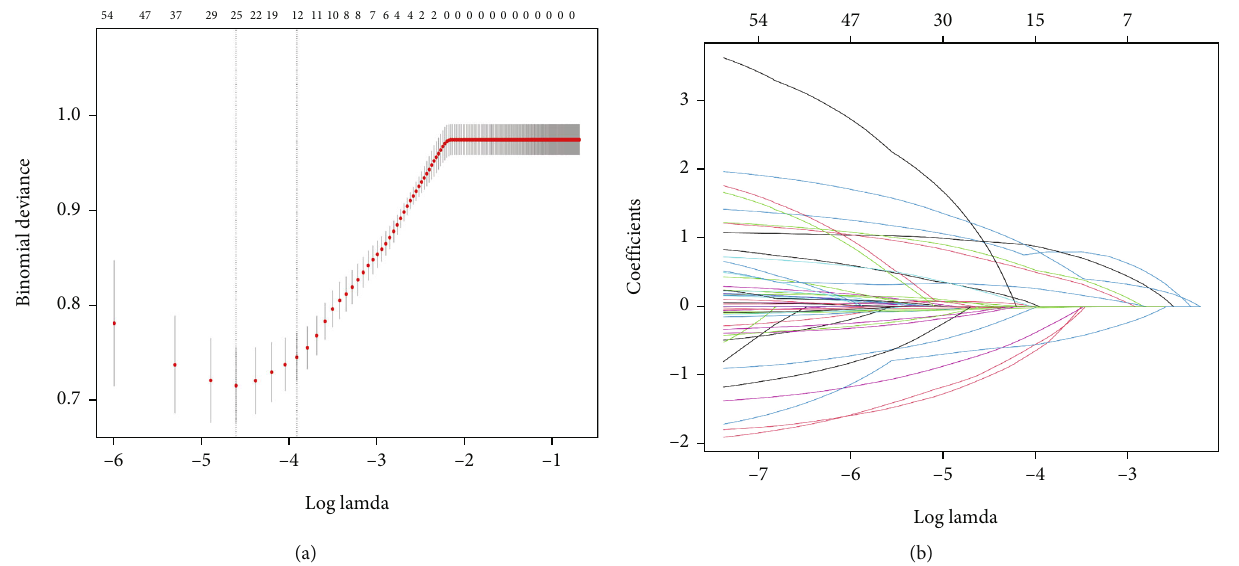
Figure 2: LASSO regression model screening predictors of CI-AKI. (a) LASSO regression model cross-validation plot. Draw a vertical line at the optimum with the minimum criterion and 1se of the minimum criterion. When λ = 0 : 0201 , we get 12 variables for further analysis. (b) Coe ffi cient pro fi le plot of predictors. Finally, nine variables were selected at the optimal lambda, which is consistent with the results selected by logistic regression. Abbreviation: CI-AKI: contrast-induced acute kidney injury. Table 2: Multivariate logistic analysis for the CI-AKI after